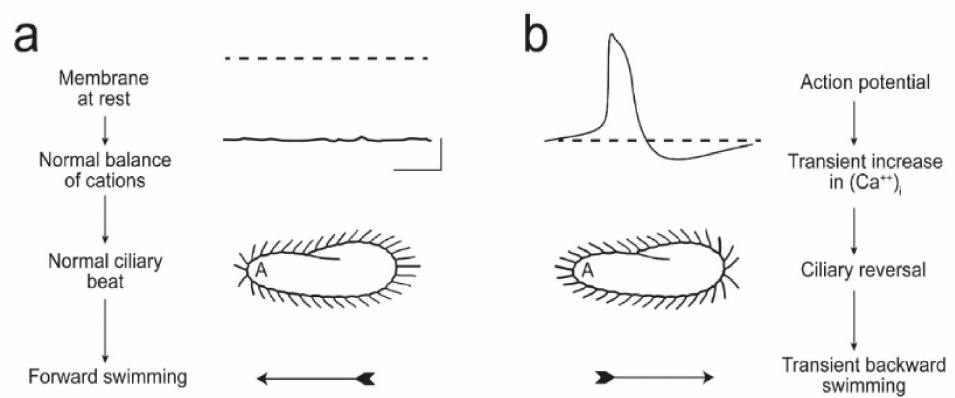
Figure 5. These images illustrate ( a ) that the resting membrane potential of Paramecium is negative; the ciliary beat is toward the posterior and cell swims forward. ( b ) In depolarizing conditions, such as high K or Ba solutions, the cell’s membrane depolarizes and reaches threshold for the action potential, during which Ca 2+ enters the cilium through Ca V channels and the Ca 2+ changes the power stroke toward the anterior, moving the cell backward. The action potential is quickly terminated, returned to resting V m levels, and the extra Ca 2+ removed. Reproduced from [20] with